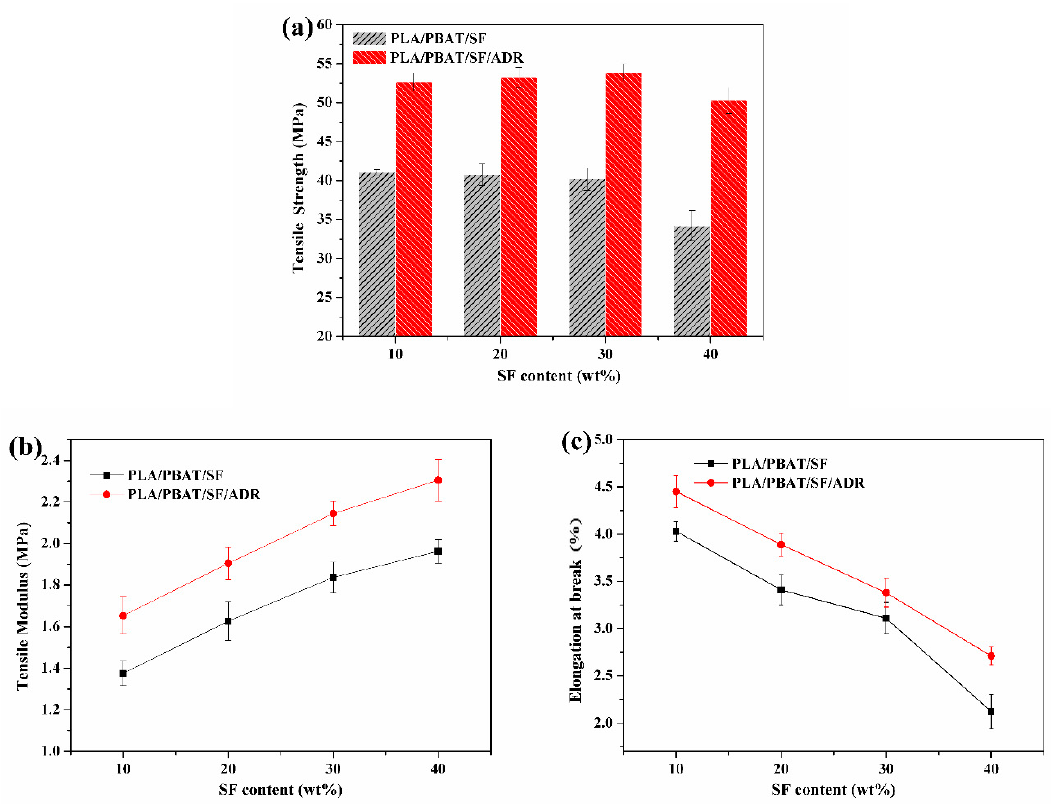
Figure 9. Tensile strength ( a ), tensile modulus ( b ), and elongation at break ( c ) of PLA/PBAT/SF and PLA/PBAT/SF/ADR composites.